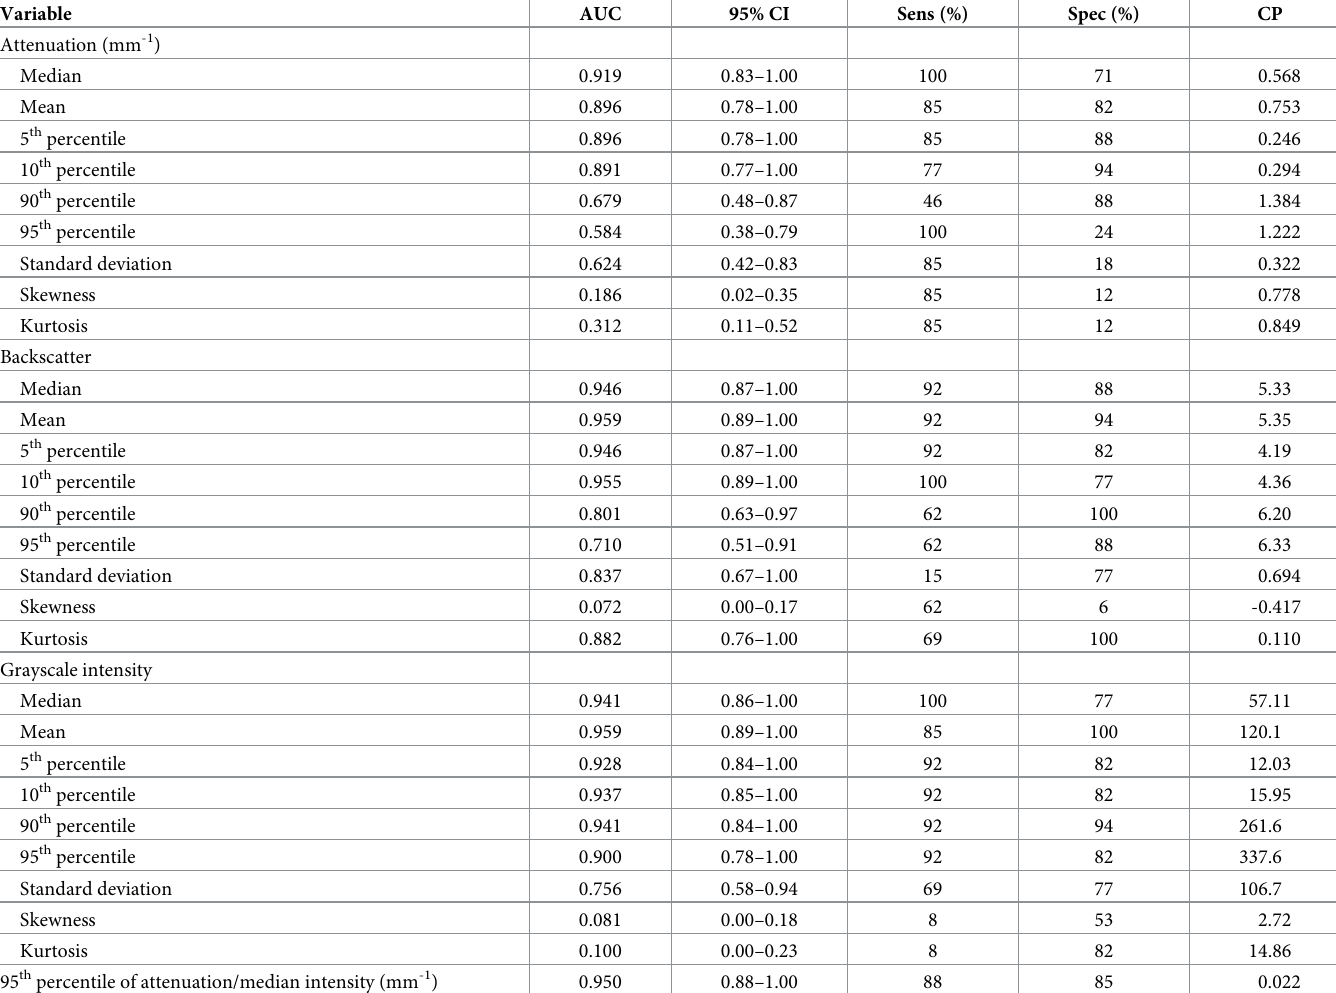
Table 4. Results of receiver operating characteristic (ROC) curve analysis of values determined by QCU-CMS software in prediction of thrombus type (white vs.